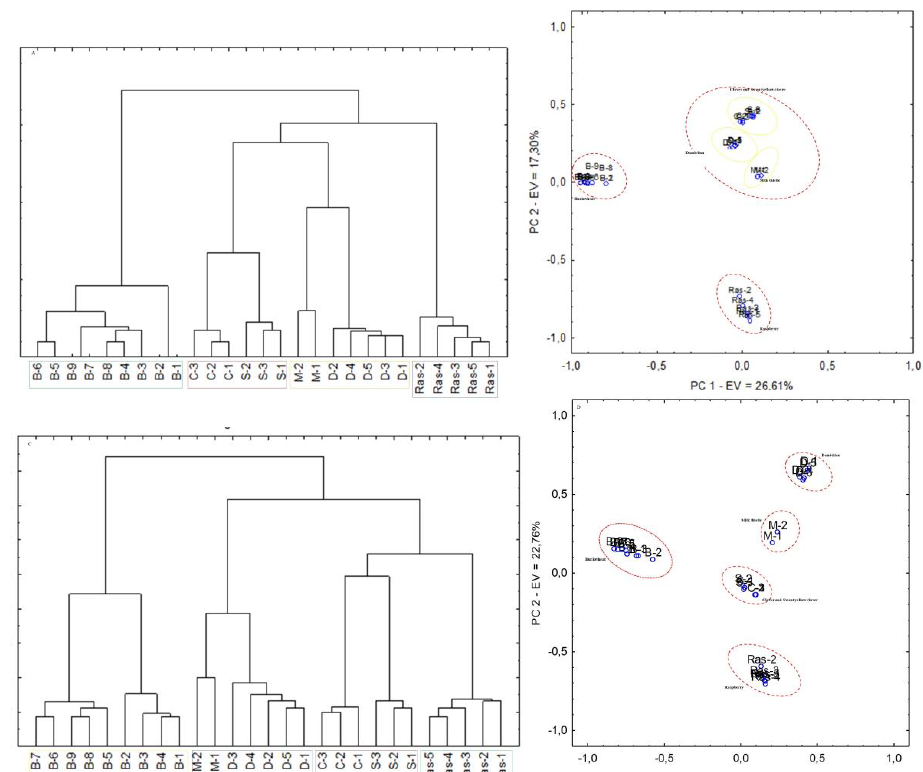
Figure 4. Exemplary statistical results for tested honey samples; ( a ) dendrogram after SPE under white light after derivatisation; ( b ) PCA score plot based on the results for SPE extracts under white light after derivatisation; ( c ) dendrogram after UAE method at 366 nm after derivatisation; ( d ) PCA score plot based on the results for UAE extracts at 366 nm after derivatisation; (Ras—raspberry honeys; D—dandelion honeys; M—milk thistle honeys; S—sweet yellow clover honeys; C—clover honeys; B—buckwheat honeys).